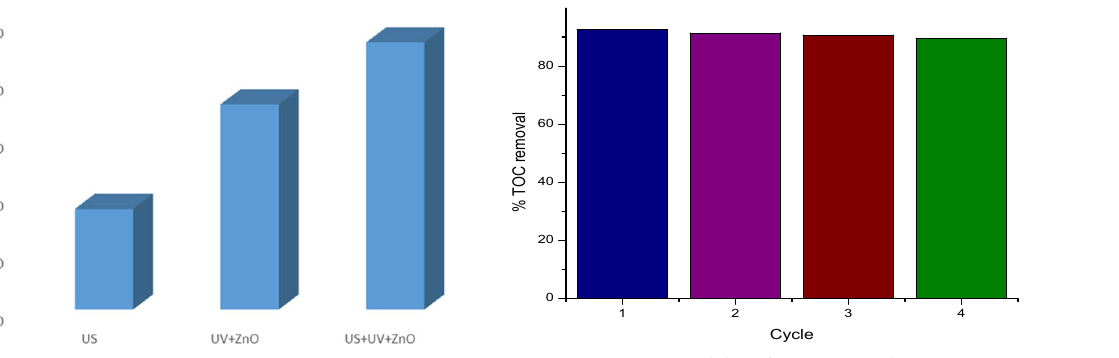
Fig. 7. Reusability of ZnO Fig. 7.Reusability of ZnOnanocatalyst